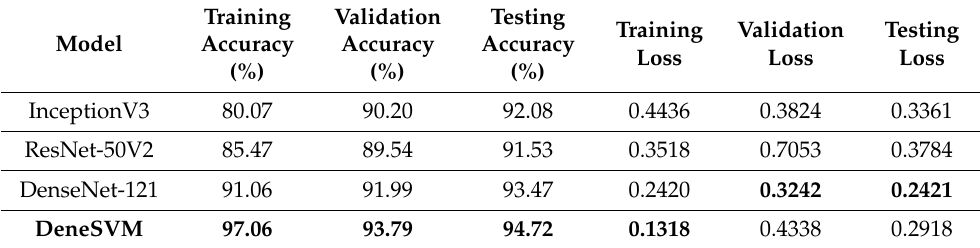
Table 5. Accuracy and loss of training, validation, and